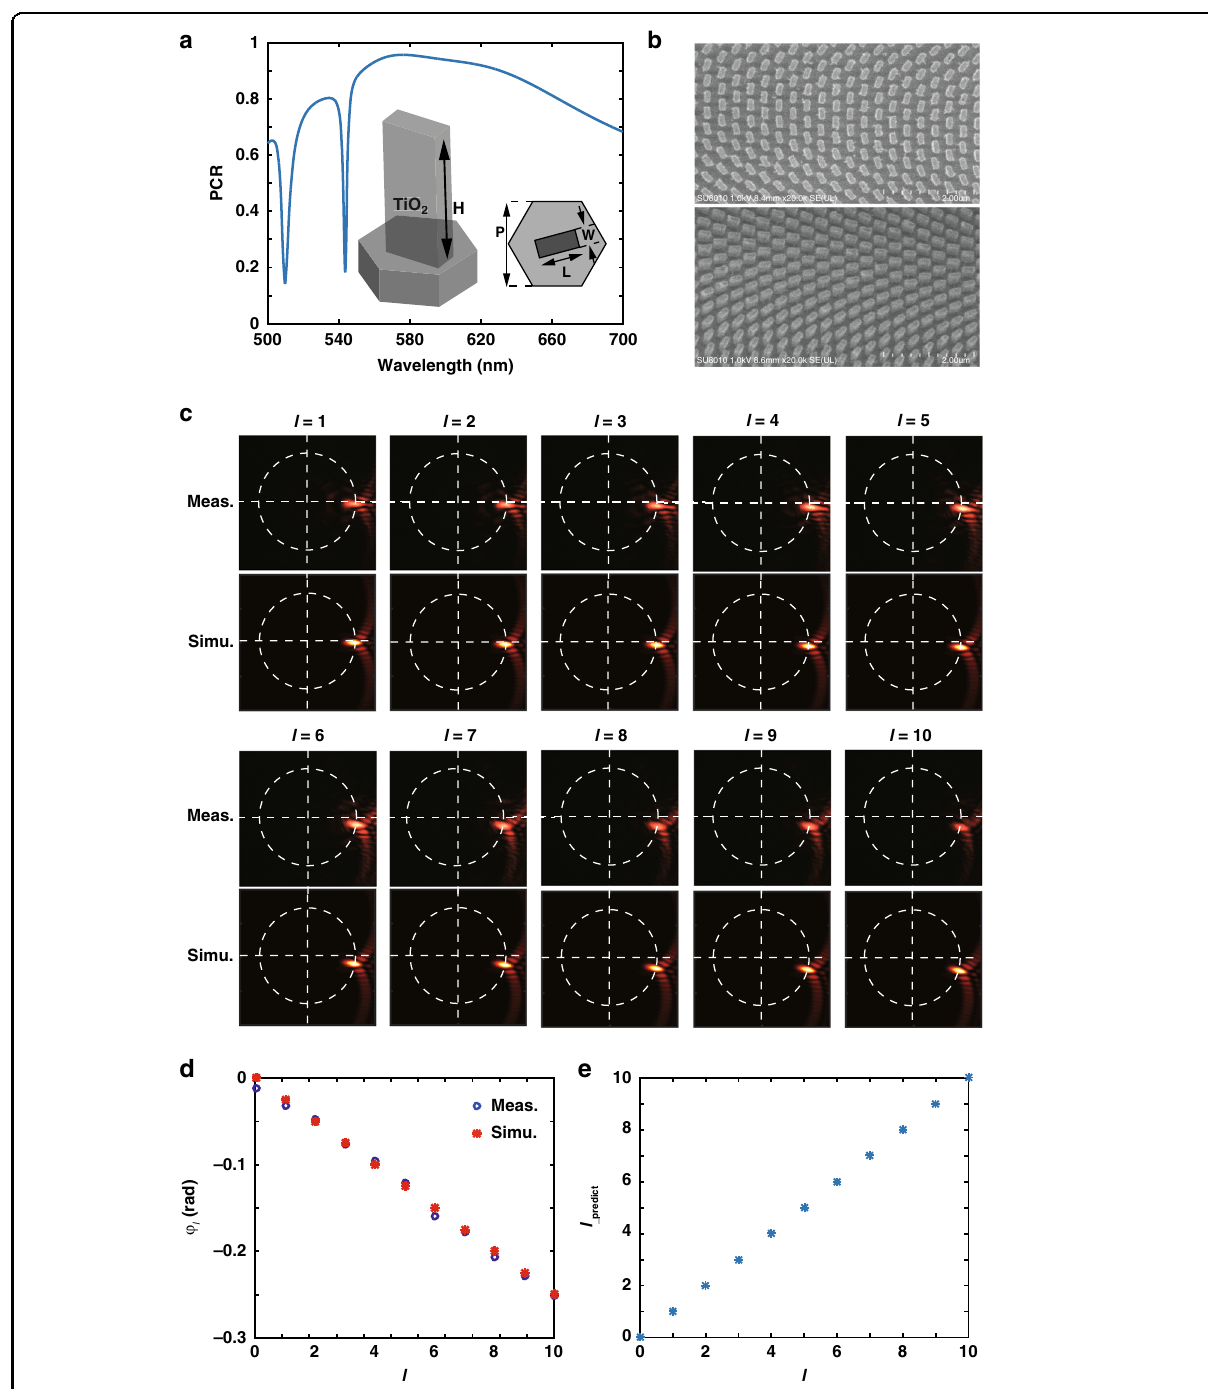
Fig. 2 Design and fabrication of geometric metasurfaces and LCP OAM sorting at a wavelength of 633 nm. a Simulated polarization conversion ratio (PCR) of the unit cell. Inset: Schematic diagram of the unit cell, which is composed of TiO 2 nanopillars on a SiO 2 substrate in a hexagonal lattice. H = 800 nm, P = 300 nm, L = 240 nm, and W = 100 nm. b Top-view and perspective-view scanning electron microscopy (SEM) images of the fabricated geometric metasurfaces. c Measured and simulated focusing patterns for different OAM modes with the topological charge increasing from 1 to 10. d Theoretical and measured azimuthal coordinates of the focus peak versus the topological charge. e OAM prediction results based on the measured azimuthal coordinates in ( d